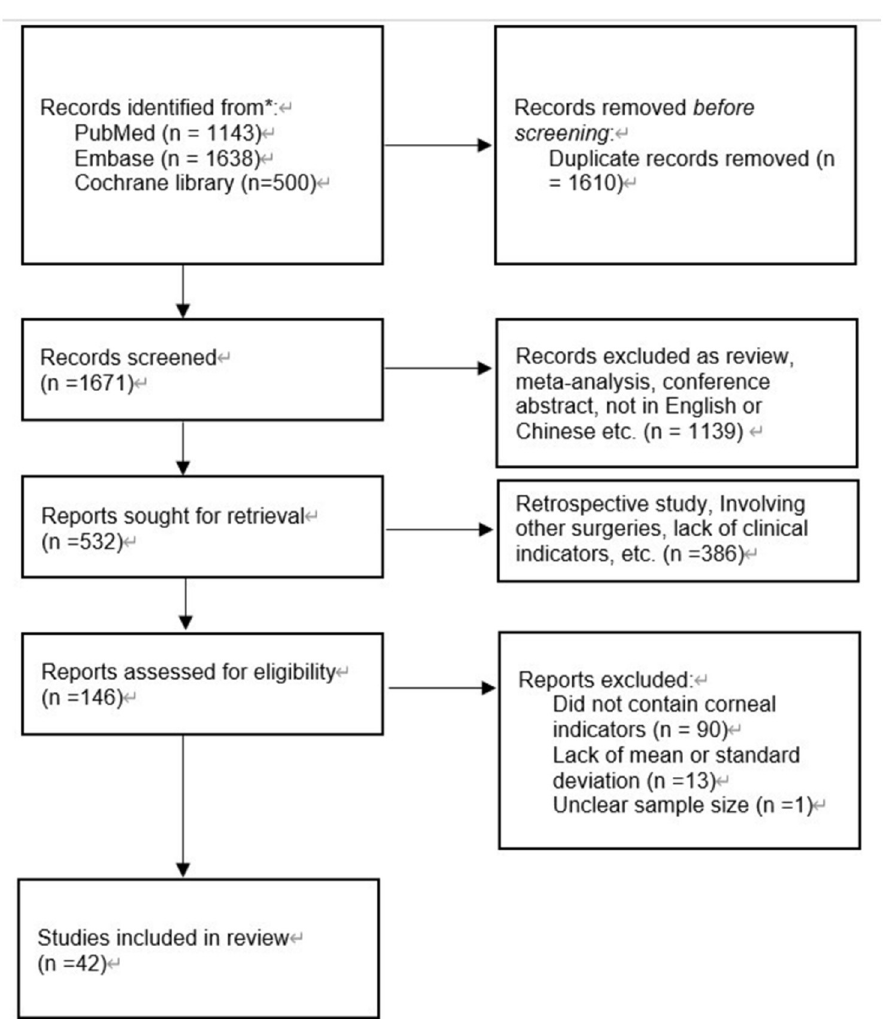
Fig 1. Flow diagram for identification of relevant studies on the corneal impact of FLACS and